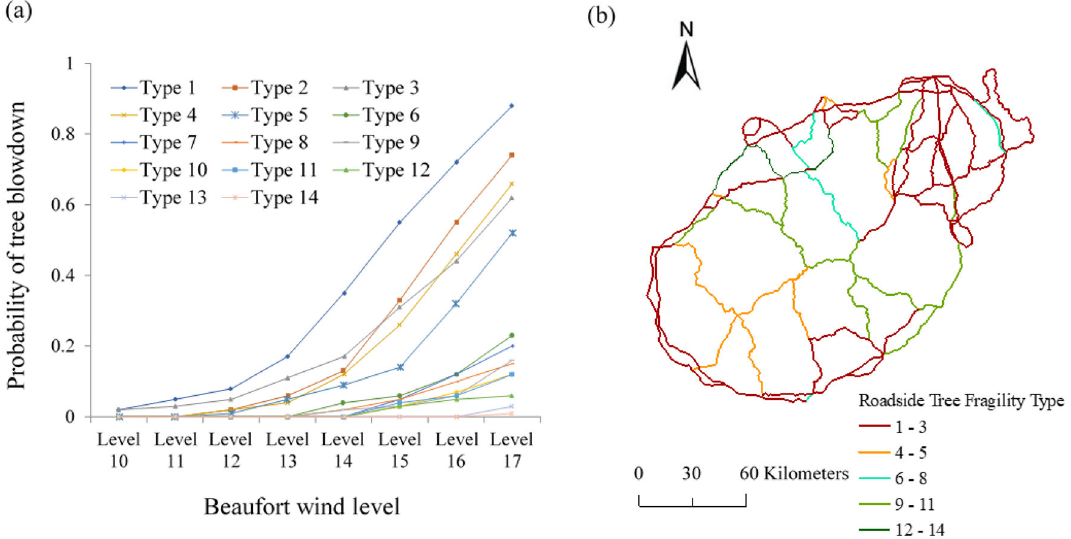
Fig. 4 Roadside tree species on Hainan Island. a Fragility curves of different species; b Spatial distribution of roadside tree species based on fragility curve